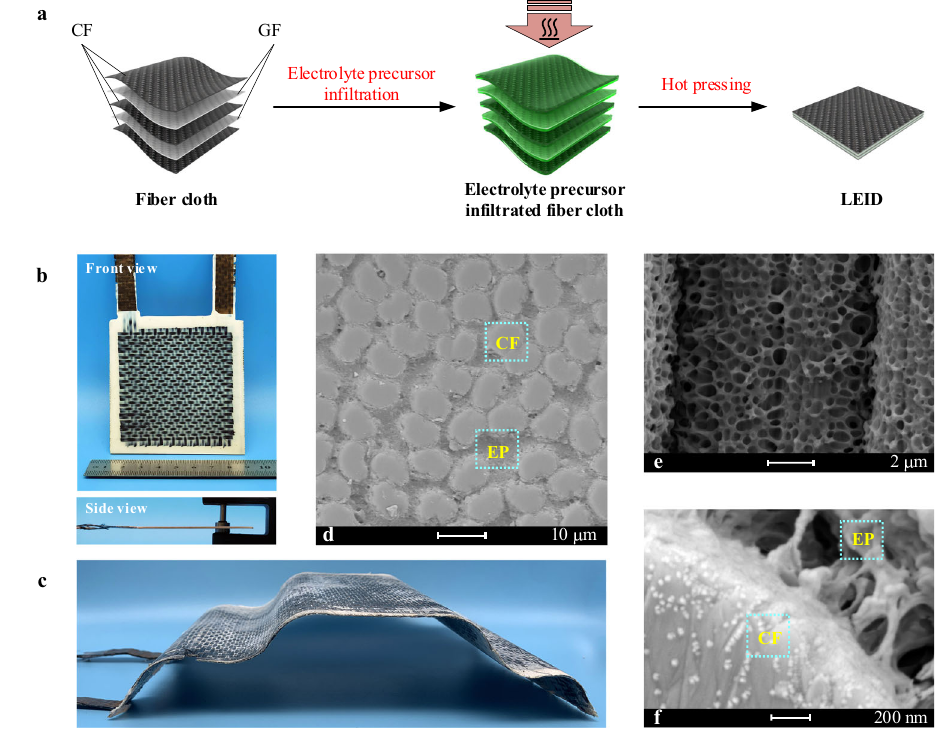
Fig. 2 | Preparation and structure of LEID. a Schematic diagram of the prepara- tion of LEID. b Front view and side view of a supercapacitor with three-layered structureplate. c ImageofacarmodelshellmadeofLEID-3. d SEMimageofLEID-3